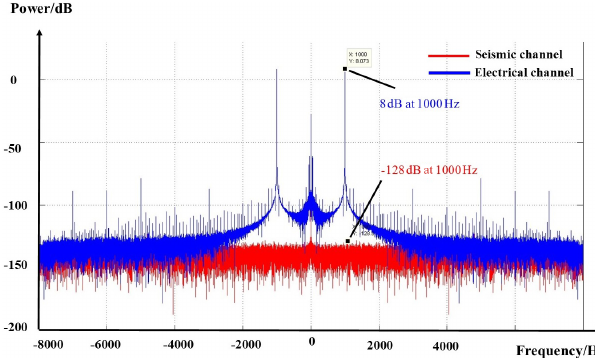
Figure 13. Spectral characteristics of signals in seismic and electri- cal channels. Table 3. Acquisition station main performance